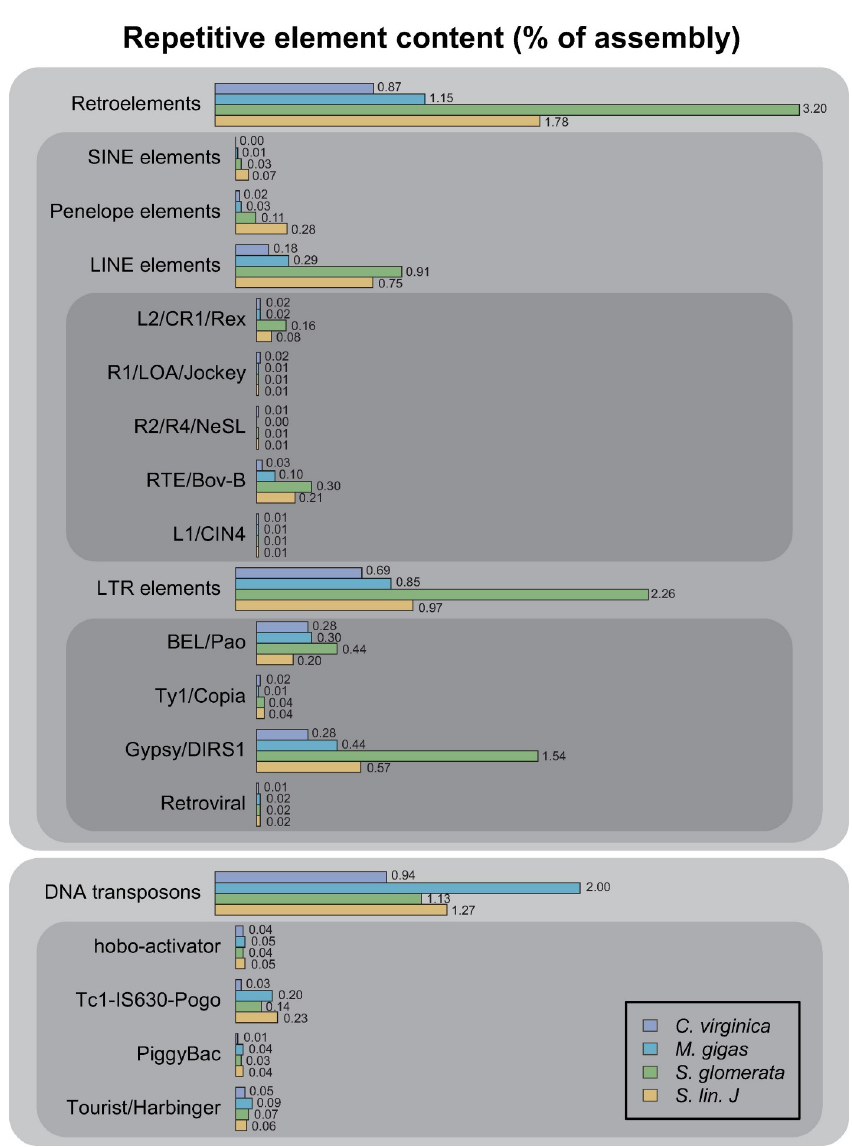
Fig 4. Repetitive element content of oyster genomes as assessed by searches against RepBase. Saccostrea species possess a greater proportion of retroelements within their genomes, particularly within the SINE , LINE , and Penelope classes. Additional expansion of the Gypsy/DIRS1 LTR class is evident in S . glomerata